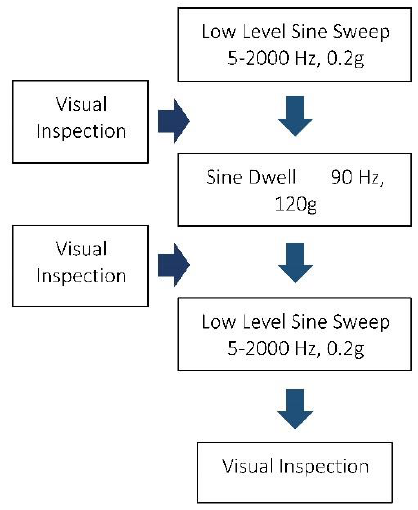
Figure 11. Structural testing flow.